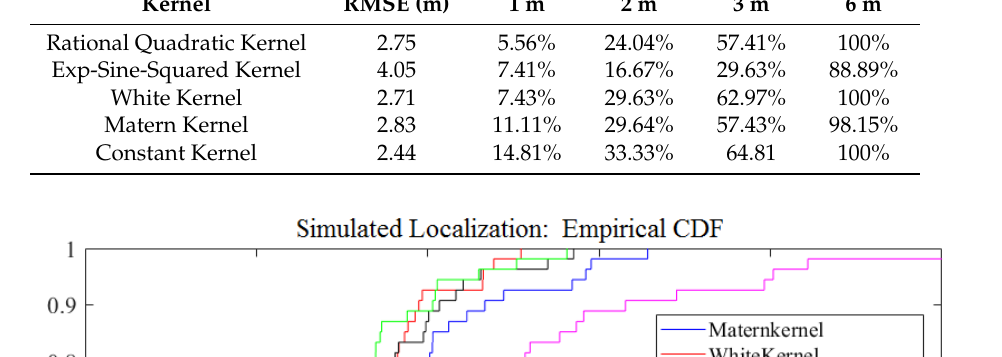
Table 3. Localization results in testing area.